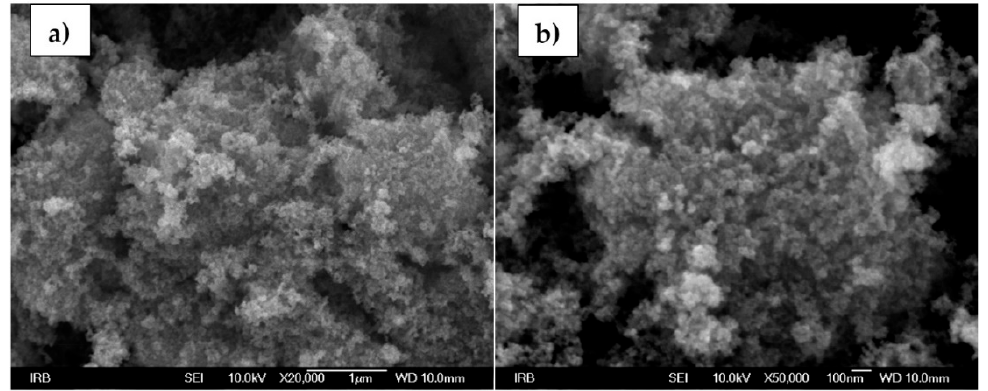
Figure 11. SEM images of magnetite NPs at a ( a ) 20,000× and ( b ) 50,000× magnification.